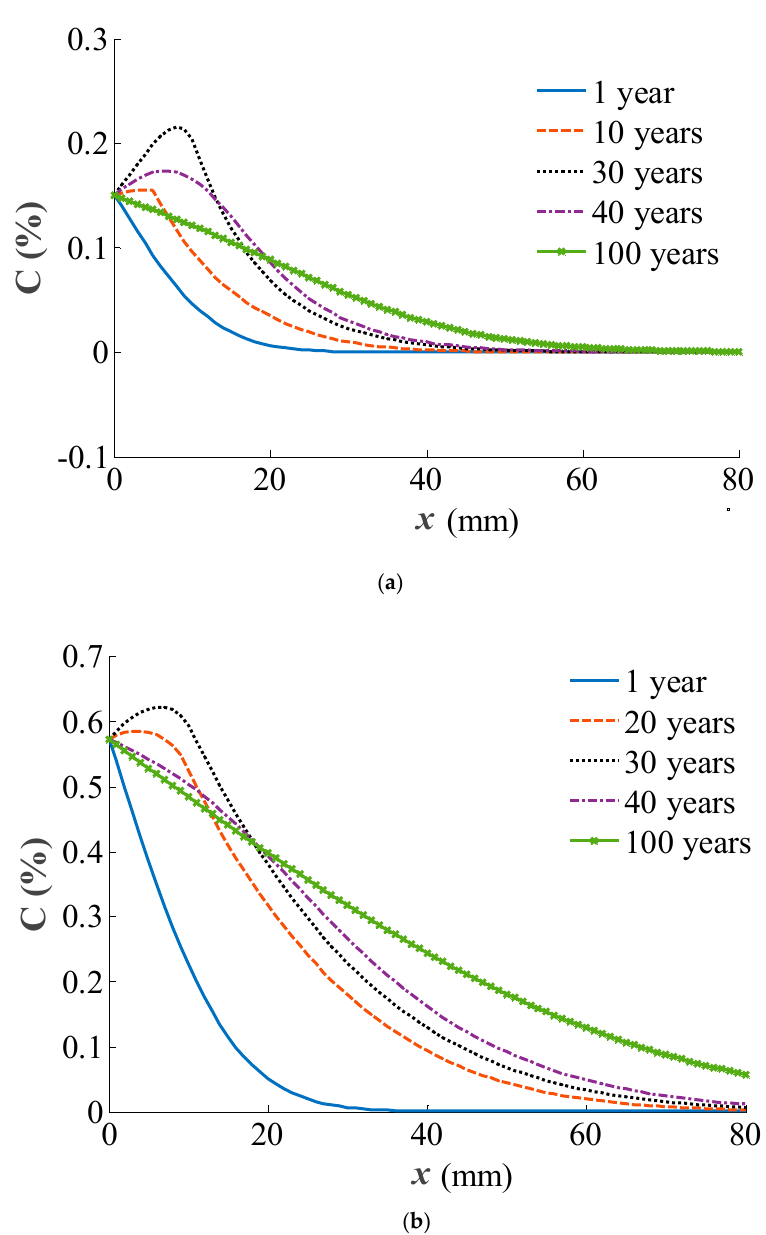
Figure 6. The relationship between concentration of the chloride ion and the calculation depth in the ( a ) inside and ( b ) outside of the lining.